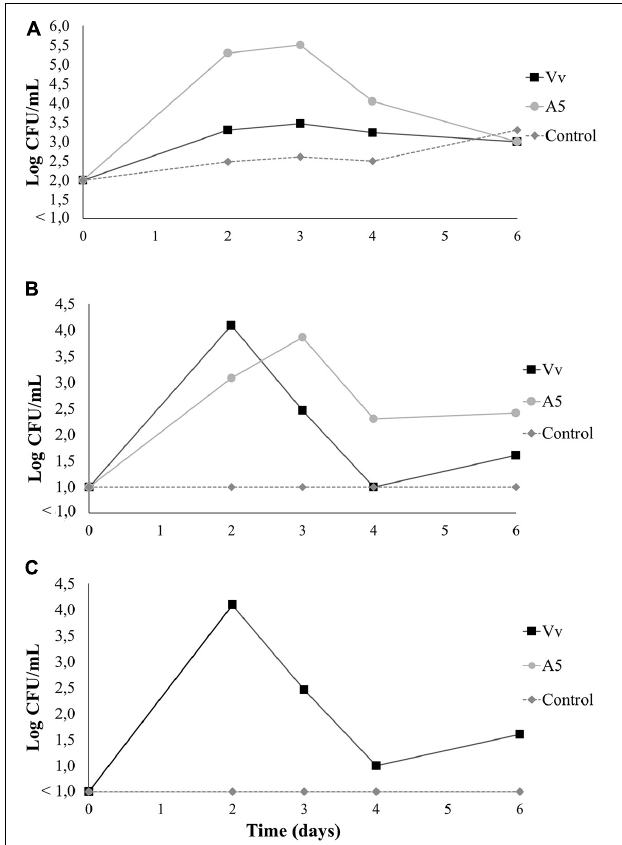
FIGURE 6 | Total aerobic bacteria (A) , total vibrio (B) , and Vibrio vulnificus (C) levels in oysters from bioassay 2 (inoculation with V. vulnificus prior to inoculation with A5). Three treatments are shown: Vv inoculated with V. vulnificus only ( (cid:4) ), Vv + A5 first inoculated with V. vulnificus and then